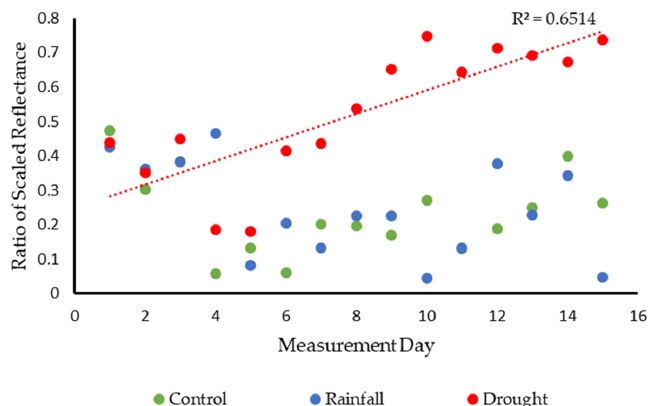
Figure 13. Change in ratio values for two key wavelengths (630 nm:550 nm) for each group further highlighting the distinct changes within the drought group. Trend line based on the drought da- taset. Note, Measurement Day represents days on which measurements were collected rather than a consecutive time